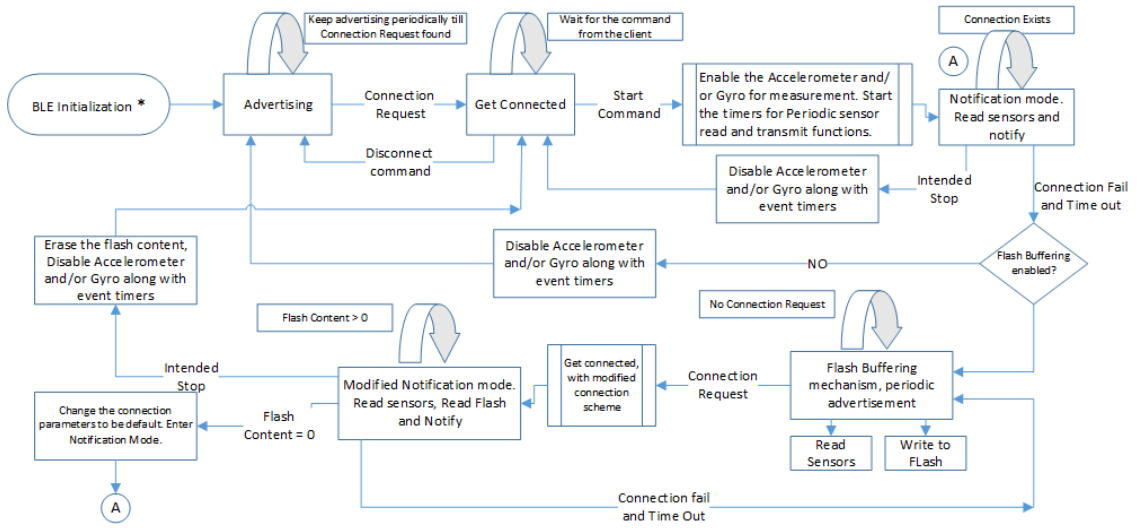
Figure 4. System operation and state flow